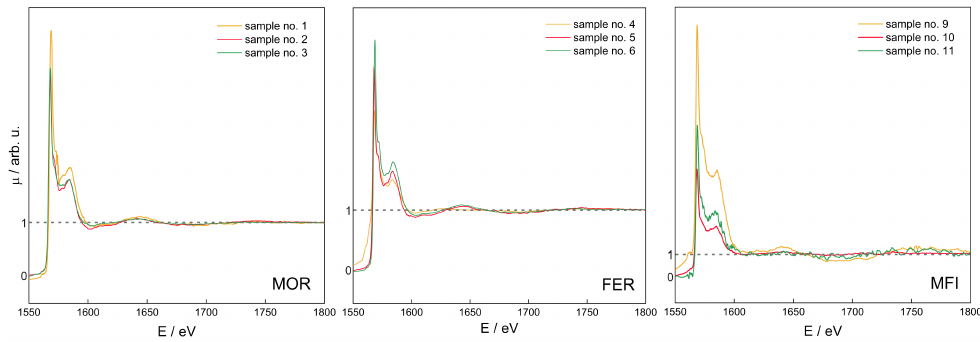
Figure 5. Normalised µ ( E ) spectra for MOR (Si/Al = 15, 10, and 8 for samples 1 *, 2, 3, respectively; left ), FER (Si/Al = 9 for samples 4, 5, 6, resp.; middle ), and MFI (Si/Al = 11.5, 25, 40 for samples 9, 10, 11, resp.; right ). * see Table 2 for sample